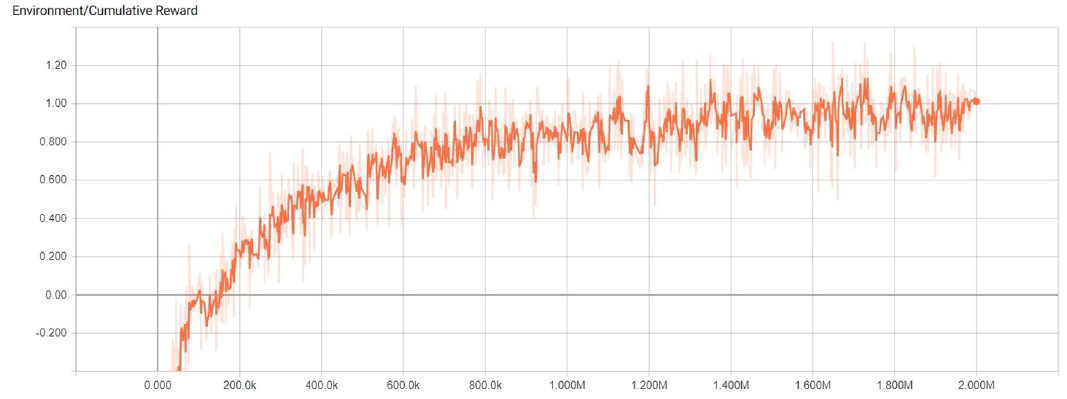
Figure 9: Learning task training